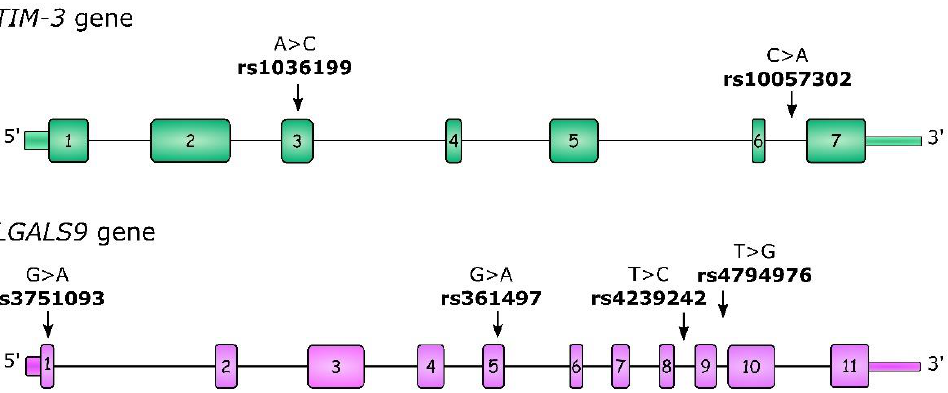
Figure 1. Structure of the TIM-3 and LGALS9 genes as well as the localization of studied single- nucleotide polymorphisms (SNPs). Boxes indicate exons and lines indicate introns, 5’UTR and 3’UTR regions.